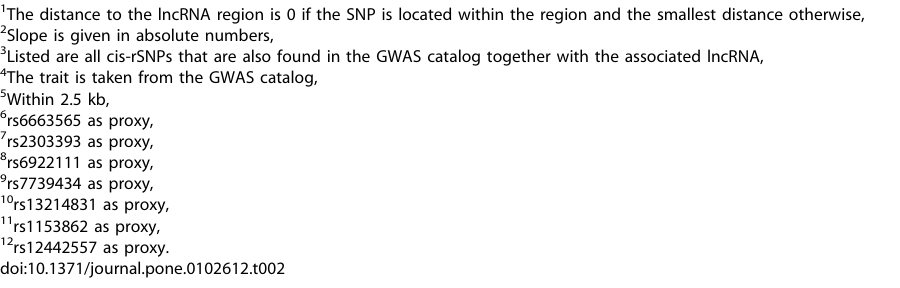
Genomic region of lncRNA